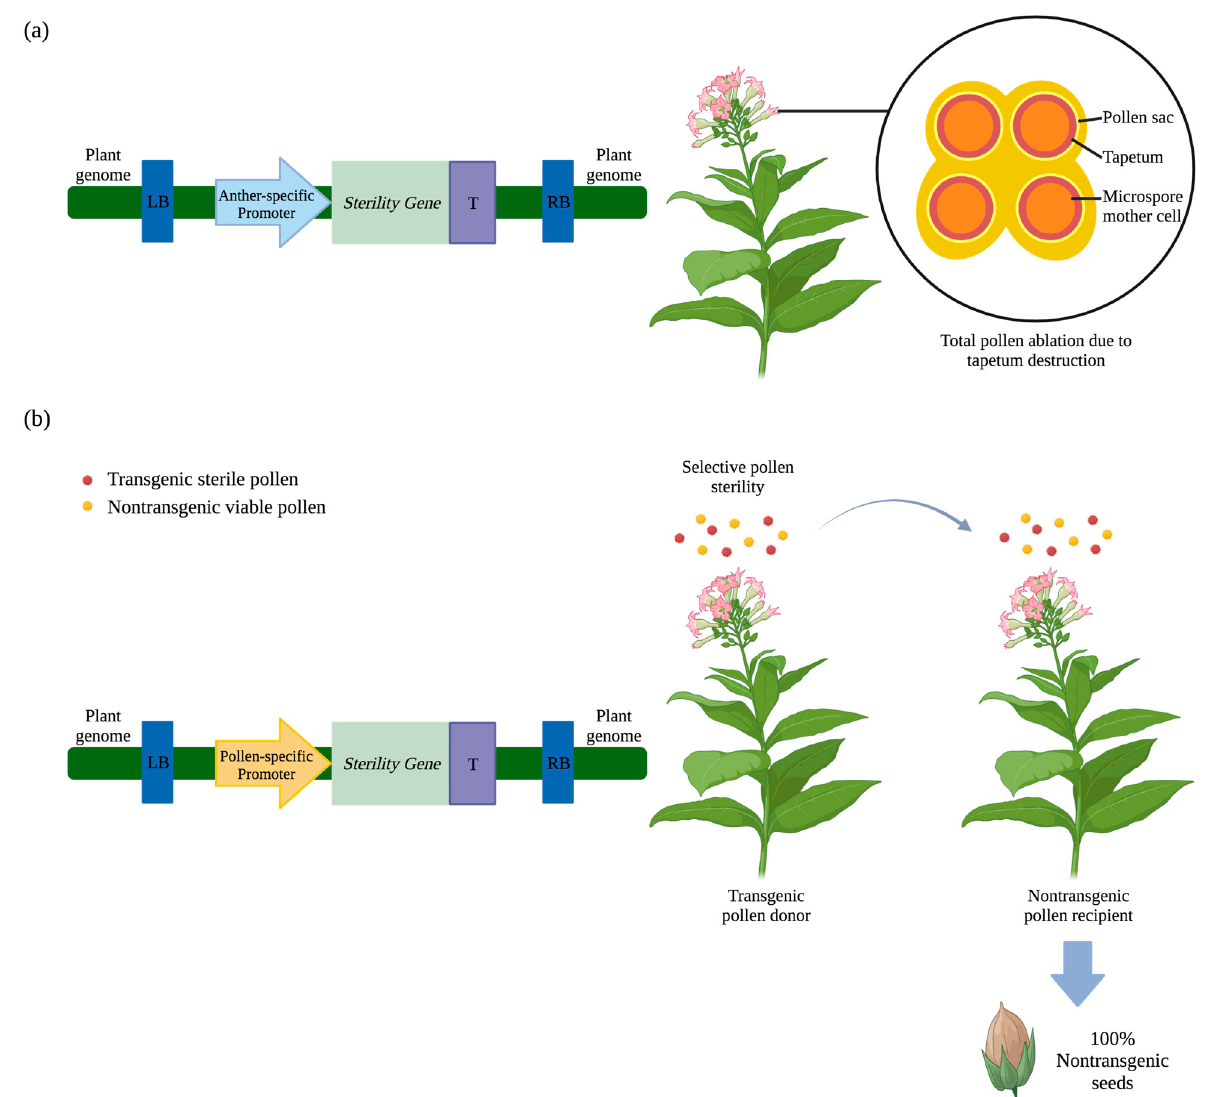
Figure 1. Engineered male-sterility approaches. ( a ) A sterility gene, such as Barnase , is located between an anther-specific promoter and a terminator (T) within the left (LB) and right borders (RB) on T-DNA inserted into the plant genome. Barnase expression prevents pollen formation by degrading RNA in the tapetal cells, the nutritive cells surrounding microspore mother cells. ( b ) A sterility gene, such as Eco RI endonuclease, is located between a pollen-specific promoter and a terminator within the left and right borders on the T-DNA, and in this example is inserted once in the plant genome. In this theoretical scenario, Eco RI expression leads to the death of transgenic pollen grains and nontransgenic pollen remains viable. Pollen movement from transgenic to nontransgenic plants yields 100% nontransgenic seeds. Figure created with Biorender.com, accessed on 22 February 2023.